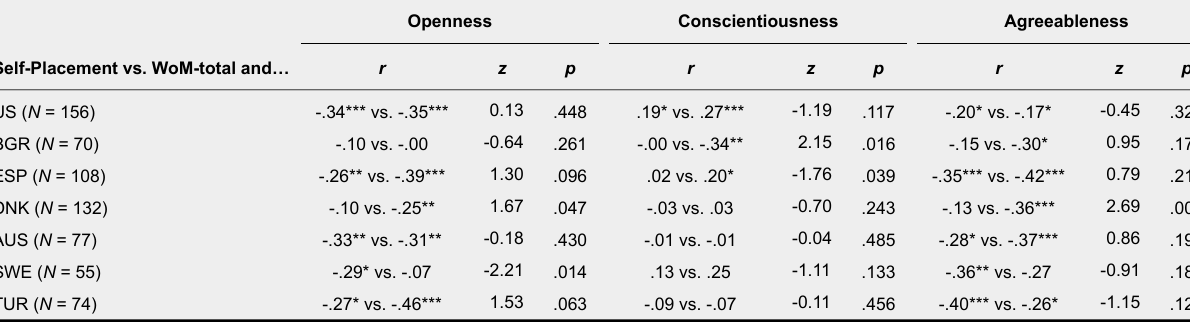
Note. Age and gender were